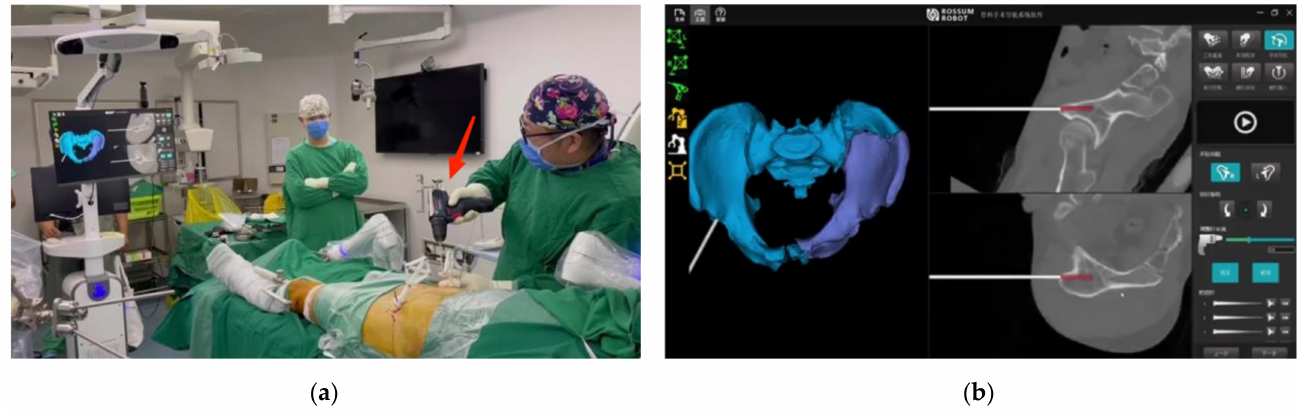
Figure 2. Imaging of the displaced pelvic fracture with fracture mapped by red dotted line: ( a ) AP view; ( b ) outlet view; ( c ) inlet view; ( d ) 3D reconstruction view.